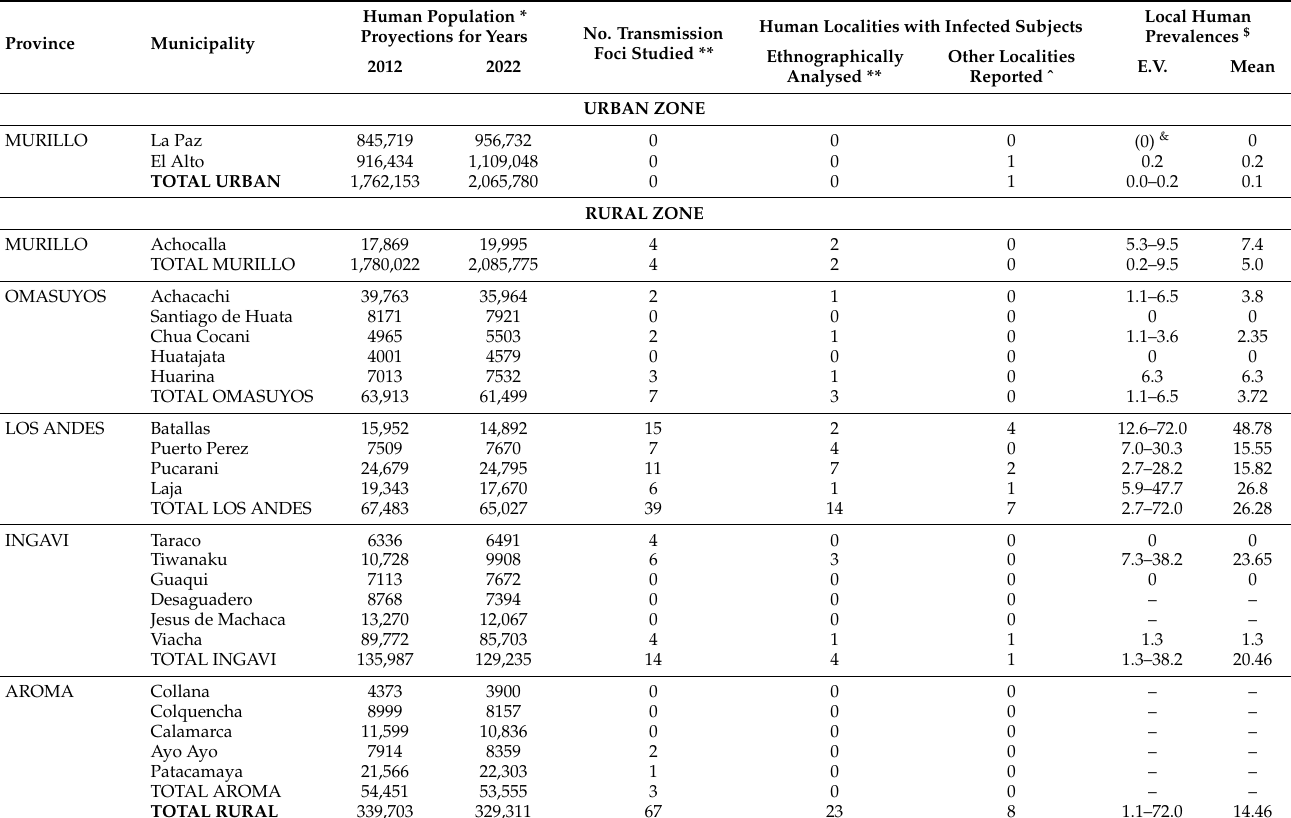
Table 2. Provinces and municipalities affected by fascioliasis in the Northern Bolivian Altiplano, showing the number of transmission foci studied and of human localities with infected subjects ethnographically analysed and respective prevalence